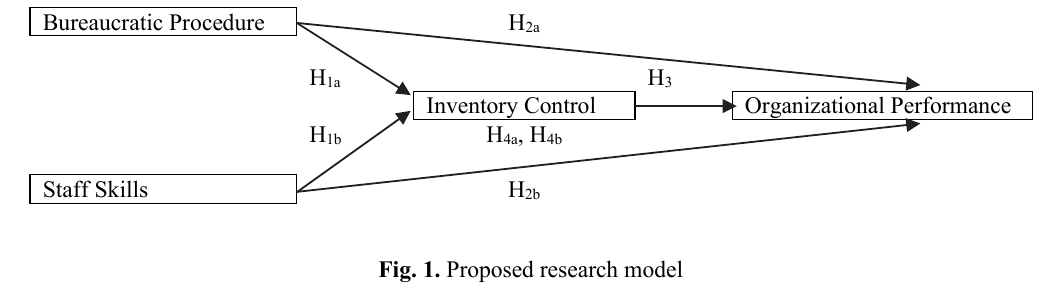
Fig. 1. Proposed research